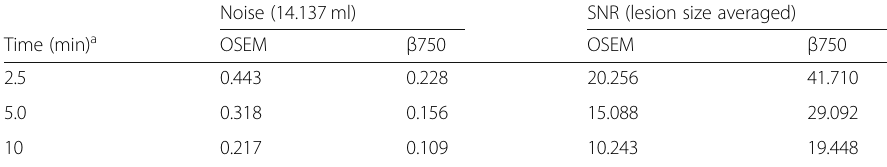
Table 4 Noise level of a large VOI ( , 3.0 cm) placed in the liver and the SNR with all lesion sizes averaged are presenting for TOF-OSEM (3 iterations, 16 subsets, post-filter 5.0 mm and PSF) and BSREM with β = 750 (including TOF and PSF). Reference values measured in a healthy liver Noise (14.137 ml) SNR (lesion size averaged)